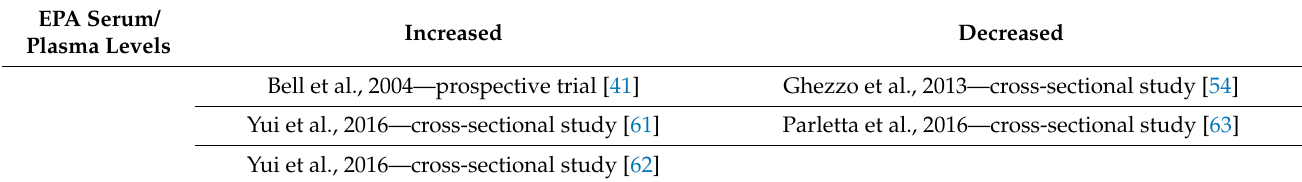
Table 6. Associations between eicosapentaenoic acid (EPA) serum/plasma levels and Autism spectrum disorders. EPA